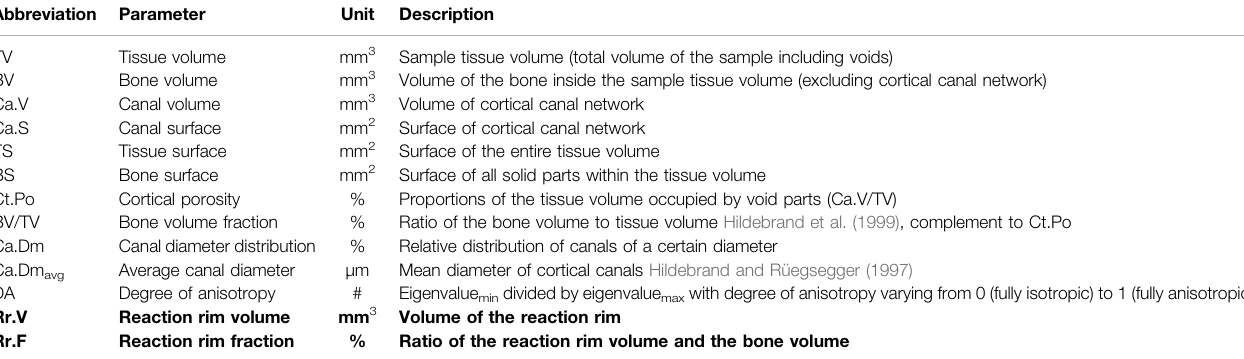
TABLE 3 | Description of the ten standard and two new (in bold font) parameters used for quantitative 3D analysis of cortical bone. Abbreviation